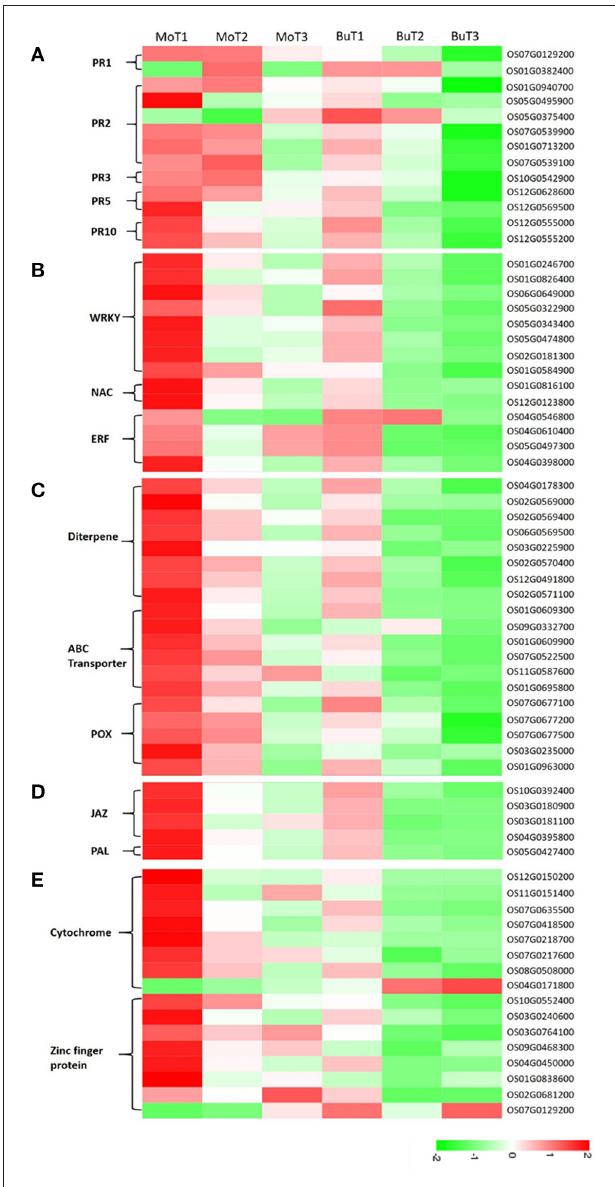
FIGURE 3 | Heat maps show increased or decreased gene transcripts in rice following MoHrip1 and buffer treatment, using the corresponding non-treated samples as controls. The bottom color bar represents the log 10 of the RPKM values for each gene, ranging from green ( − 2) to red (2). A comparison of the gene expression levels in rice after treatment with MoHrip1 and buffer for the PR proteins (A) ; transcription factors (B) ; phytoalexin-, ABC transporter-, and peroxidase-related genes (C) ; SA and JA pathways (D) ; and CYP450- and ZFP-related genes (E) .